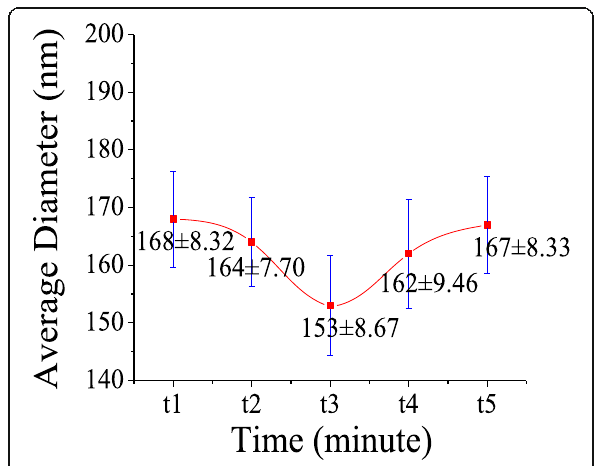
Fig. 8 The effect of spinning time on the average diameter of PVA